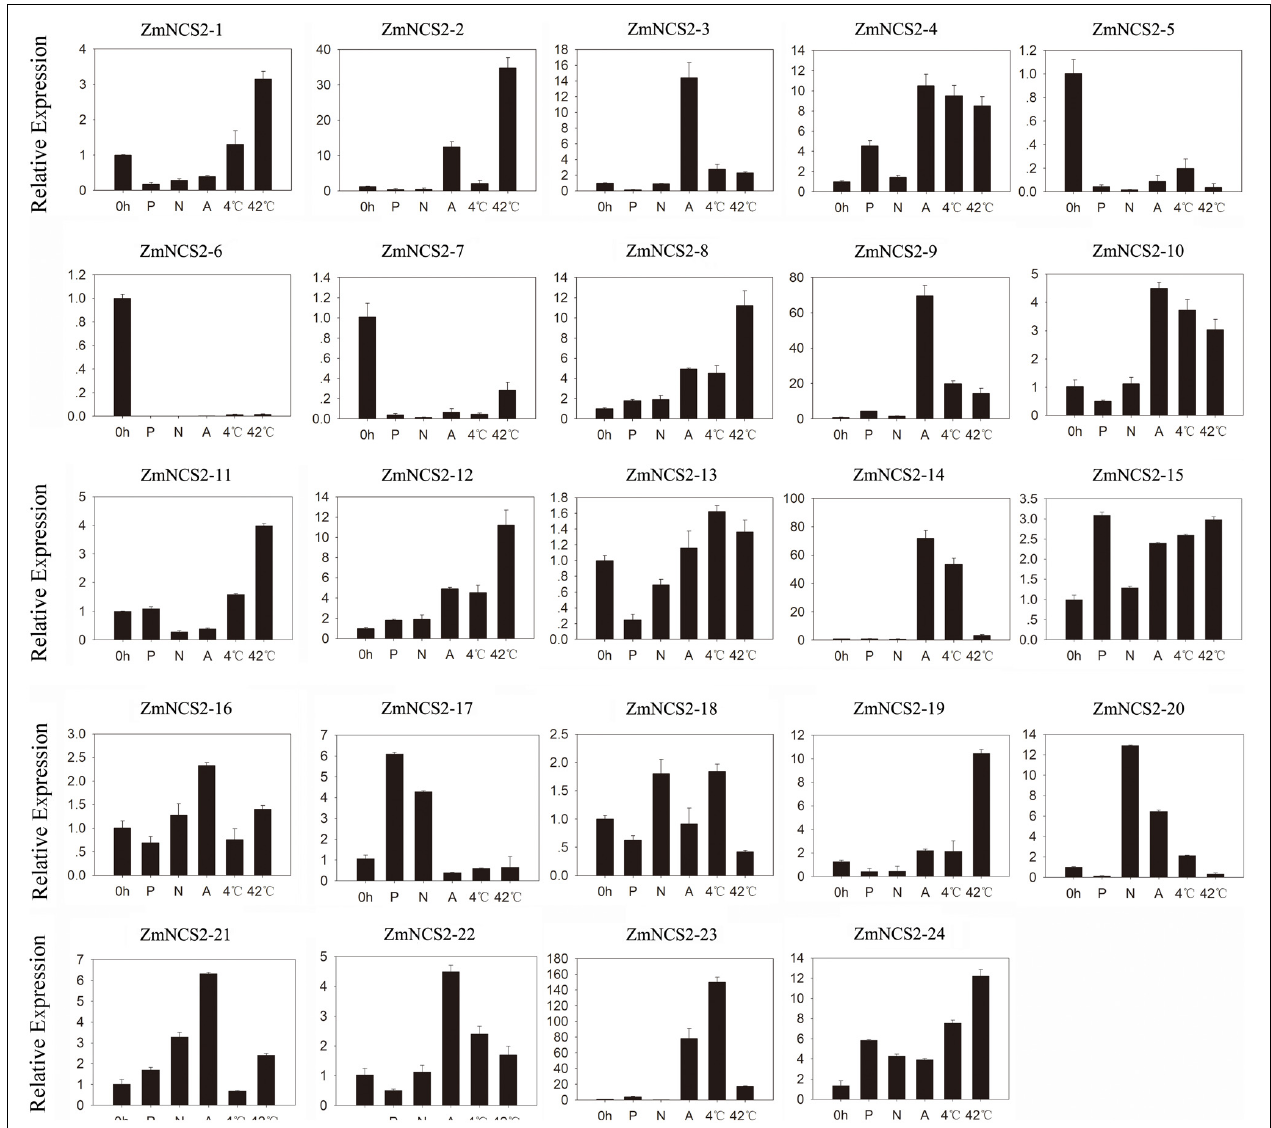
FIGURE 7 | Expression patterns of five stress-responsive ZmNCS2 genes in response to various stress treatments. Relative expression levels and stress treatments (PEG, ABA, NaCl, 4 ◦ C, and 42 ◦ C) are indicated on the y -axis and x -axis,